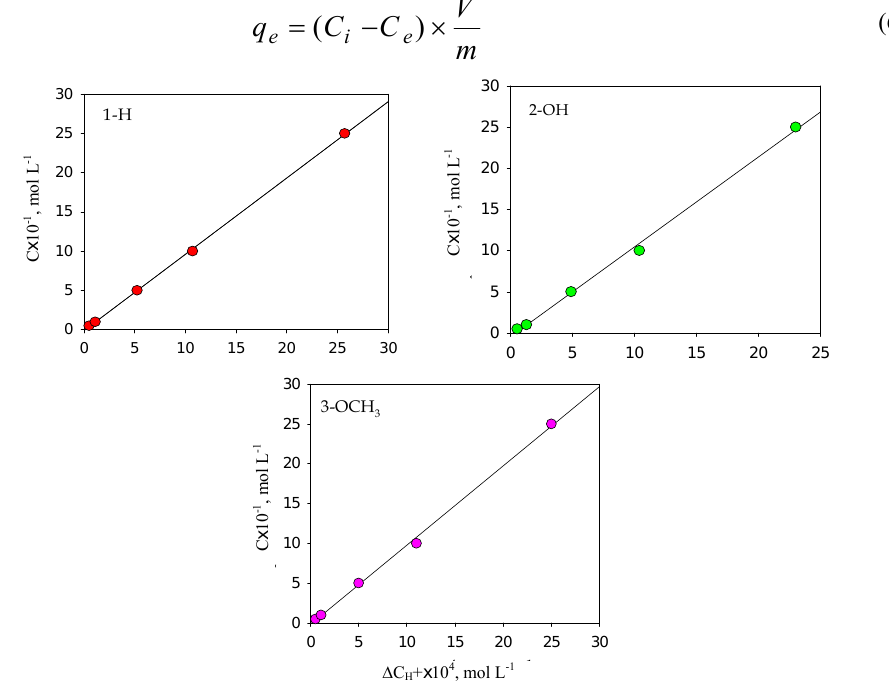
Figure 3. The relation between the initial concentration (C and the concentration of hydrogen ion released at equilibrium ( Δ C